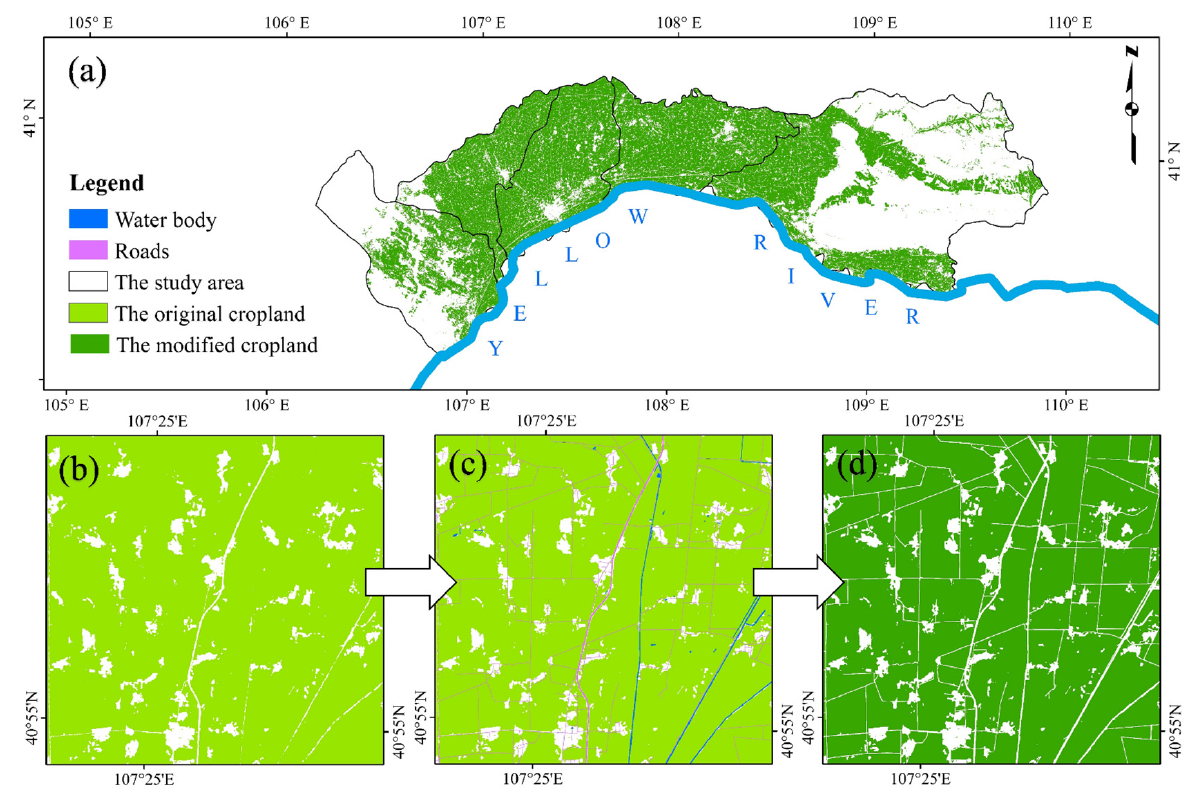
Figure 4. Cropland distribution in HID, ( a ) HID base map of modified cropland, ( b ) detailed map of initial cropland of ESA WorldCover global land cover data at 10 m resolution, ( c ) detailed SHP file of roads and ditches downloaded from AutoNavi Electronic Maps, ( d ) detailed map of modified cropland at 10 m resolution. Table 1. Cropland area derived from remote sensing data and areas included in The Third National Land